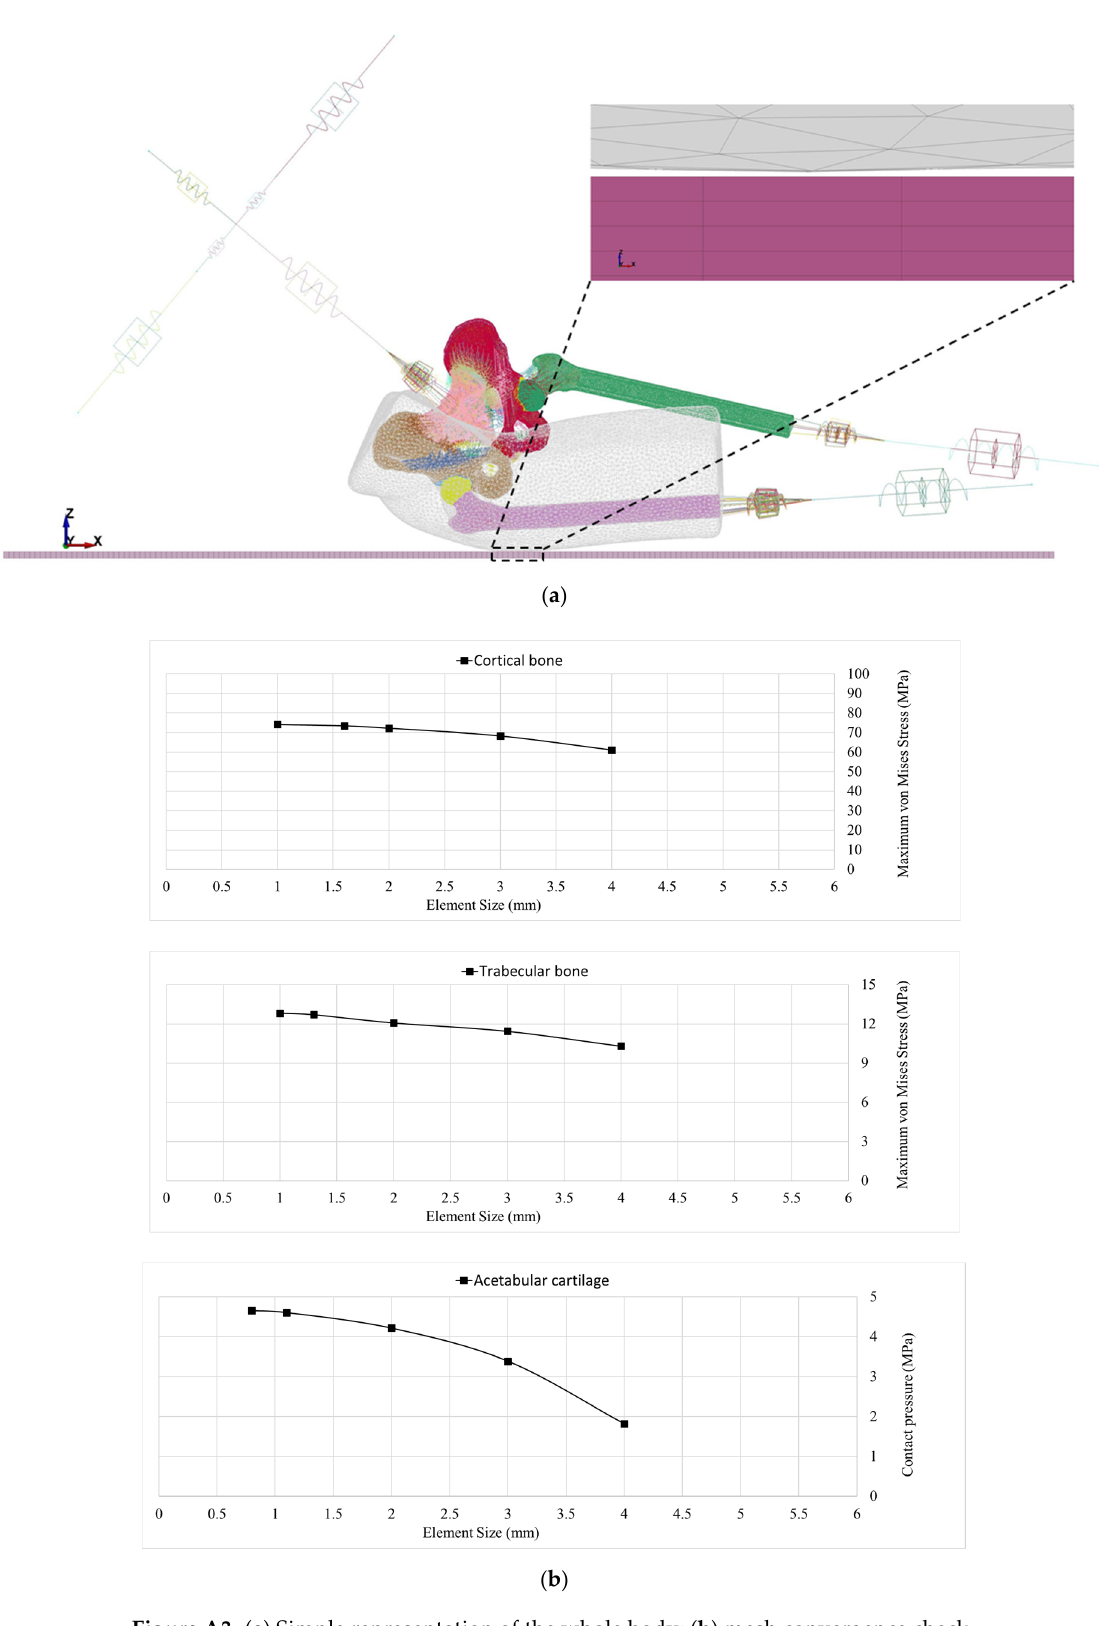
Figure A3. ( a ) Simple representation of the whole body; ( b ) mesh convergence check.